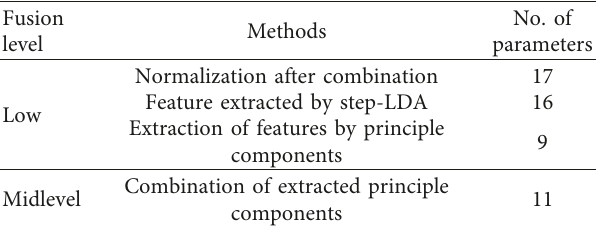
Table 2: Sensors used in α -Astree E-tongue and their thresholds (mol · L − 1 ). Basic taste